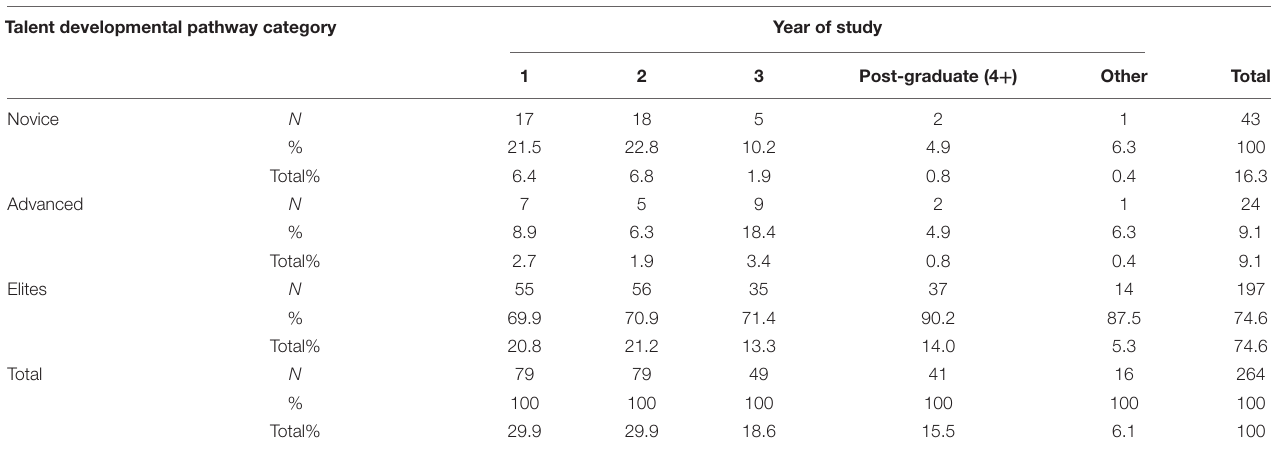
TABLE 2 | Cross-tabulation of developmental categories according to year of study. Talent developmental pathway